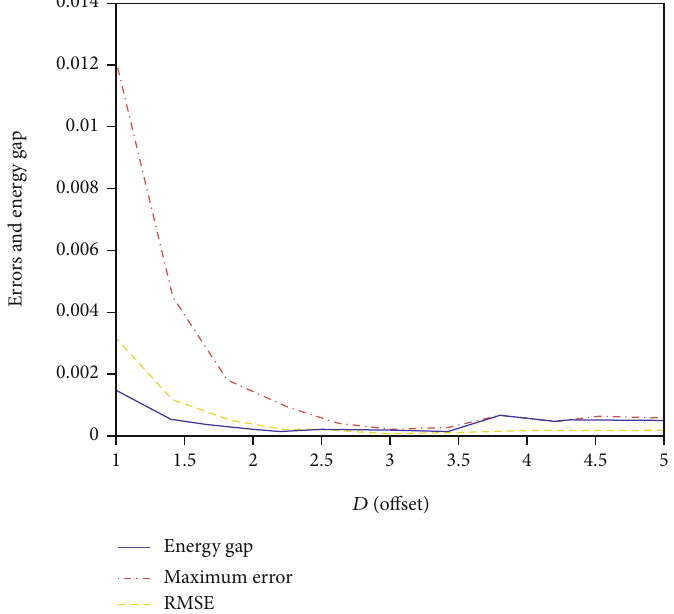
Figure 2: Determining the optimal o ff set in the MFS by minimizing the energy gap for Example